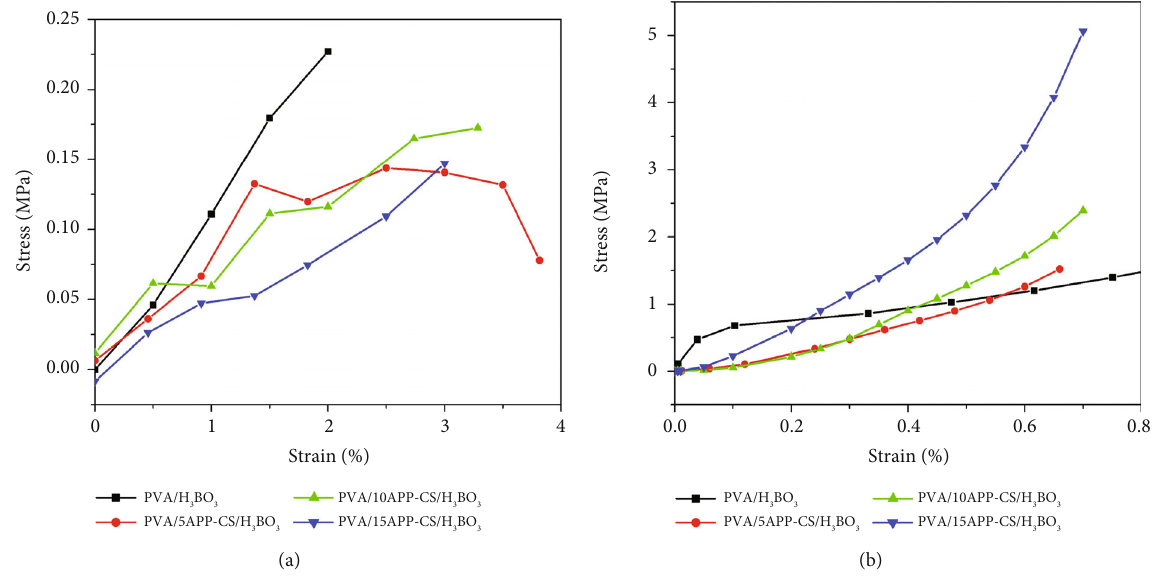
Figure 6: (a) Stress-strain and (b) compressive stress-strain curves of the PVA composite aerogels.